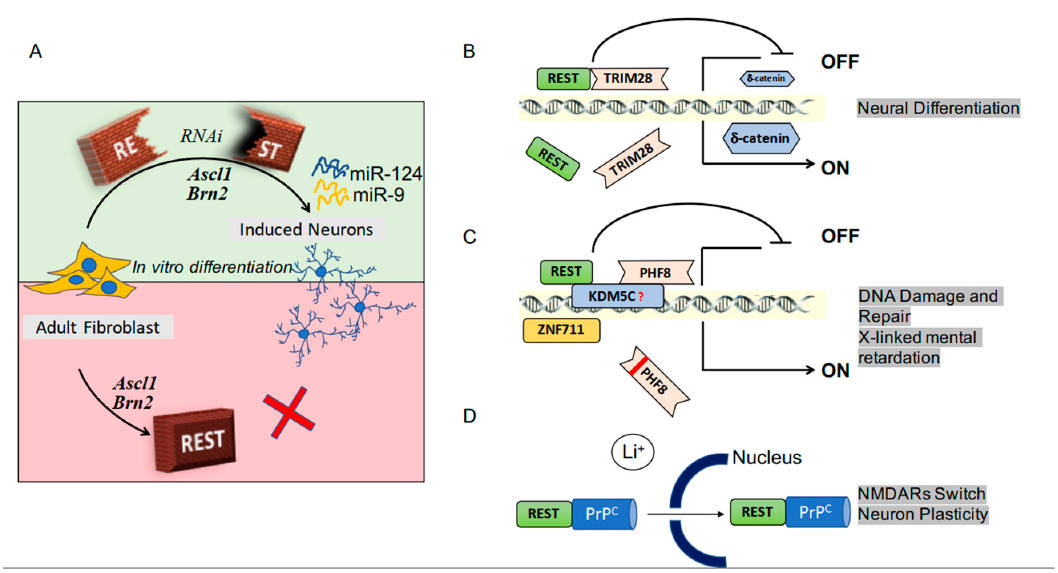
Figure 1. RE-1 silencing transcription factor (REST) activity in neuronal physiology. Panel ( A ) illustrates the role of REST in the conversion of fibroblasts into neurons. Overexpression of the genes Ascl1 and Brn2 favors the process, which is blocked by REST (see the bottom of ( A )). The latter effect of REST, however, is prevented by specific RNA inhibitor (RNAi, see the top of ( A )). The ensuing activation of two miRNAs, miR-9 and miRNA-24, act by inducing a reconfiguration of DNA, necessary for the opening of the appropriate REST binding sites. Panels ( B – D ) show examples of REST cooperation with regulatory factors. In ( B ) the participating factor is TRIM28, a universal co-repressor